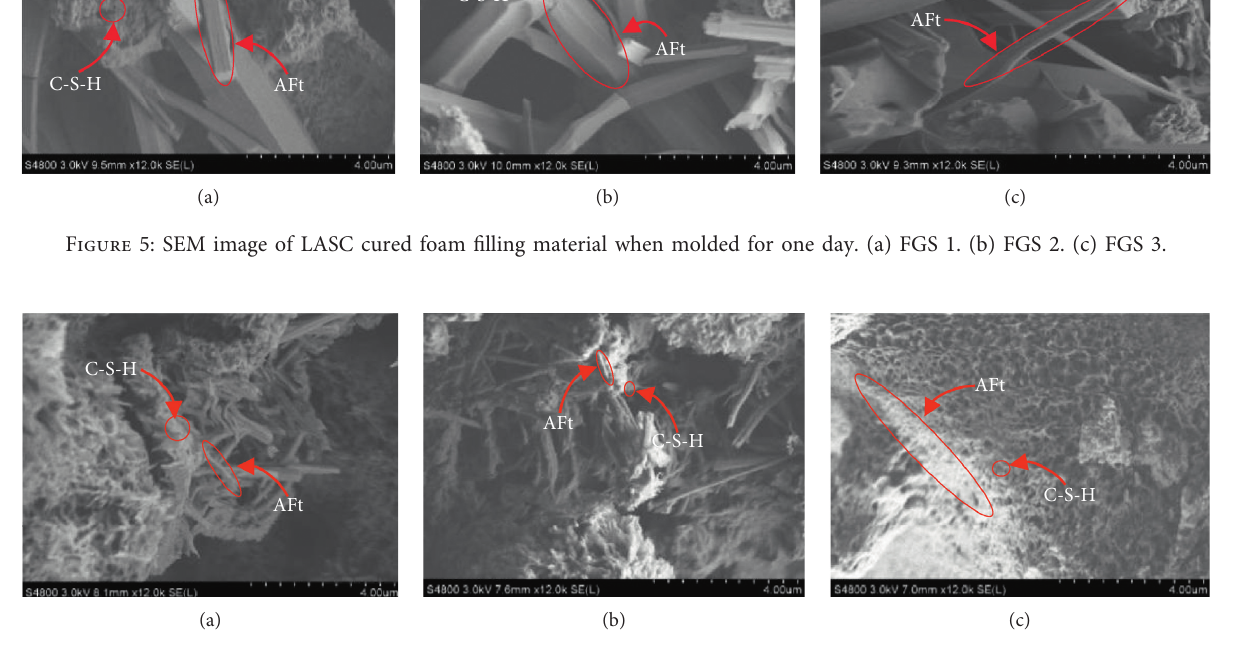
Figure 6: SEM image of OPC cured foam filling material when molded for seven days. (a) FGS 1. (b) FGS 2. (c) FGS 3.